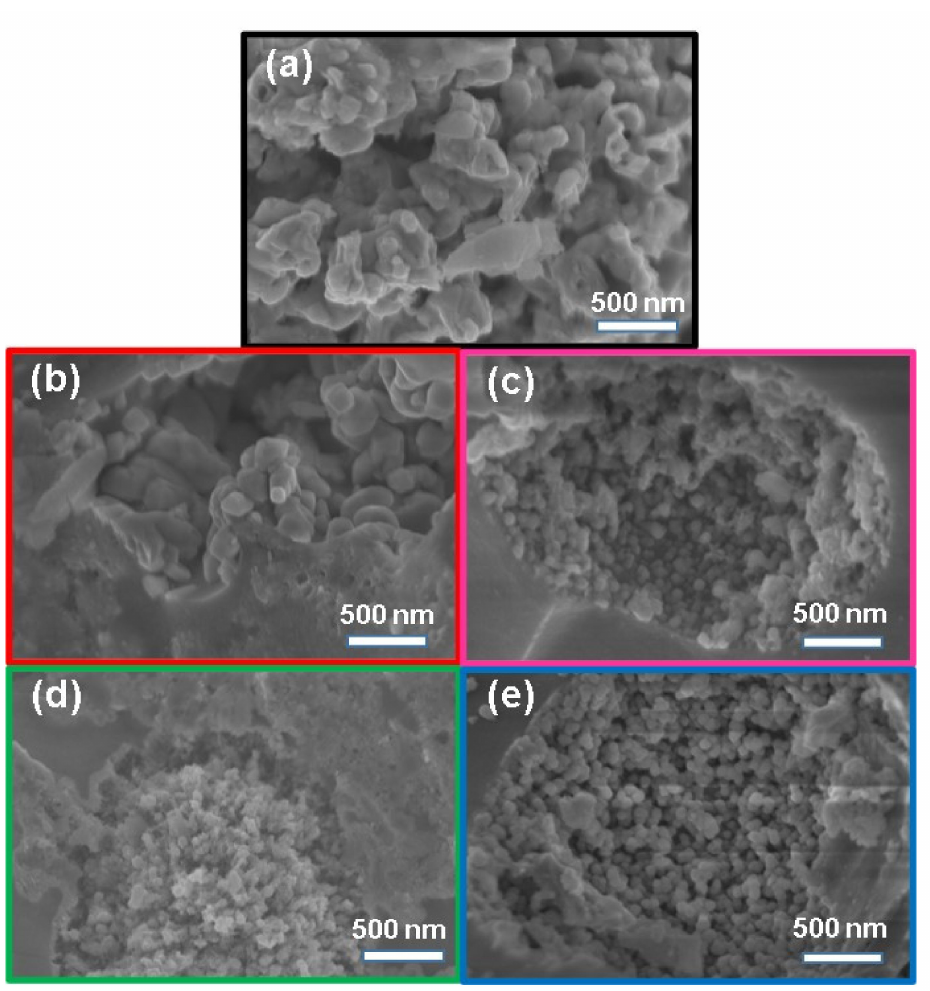
Figure 3. SEM images of ( a ) CuSi, ( b ) Cu 1 Ce 0.15 Si, ( c ) Cu 1 Ce 0.45 Si, ( d ) Cu 1 Ce 0.7 Si, and ( e ) Cu 1 Ce 0.91